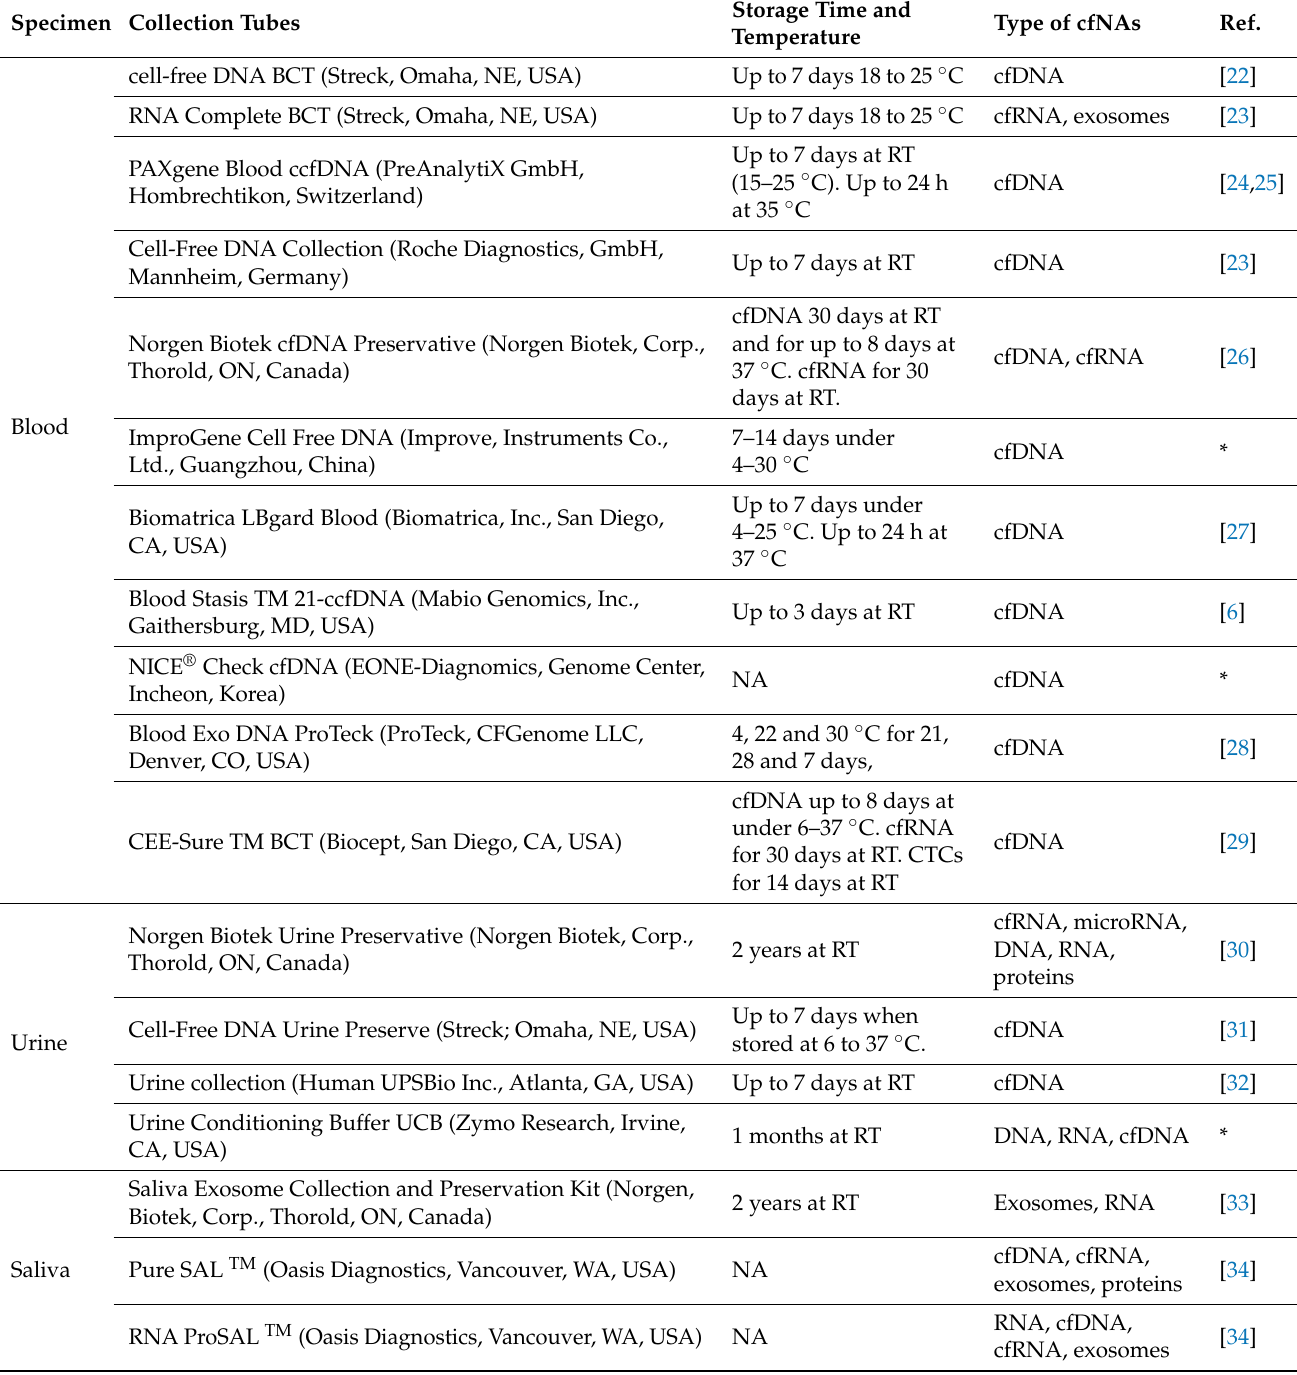
Table 1. Most common commercially available collection tubes for cfNAs preservation. For new products, no evalua- tion/comparison studies have been published to date (*). NA: not available. Specimen Collection